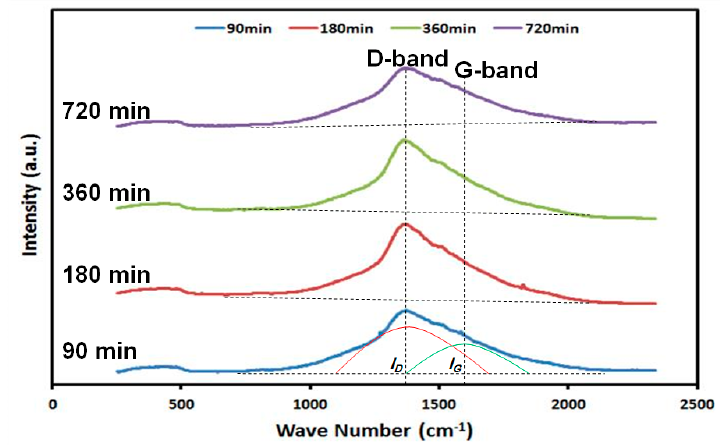
Figure 3. Laser Raman spectra of SP samples (90, 180, 360, and 720 min).